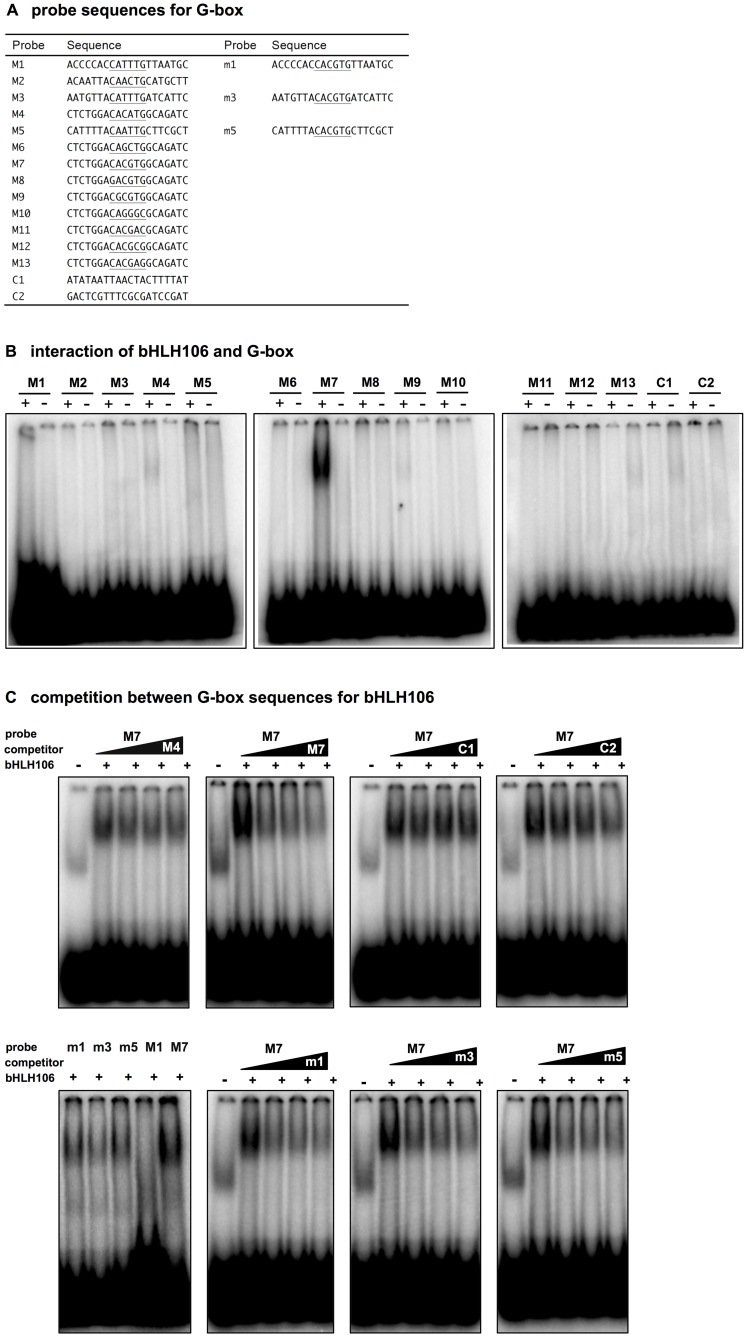
Interaction of bHLH106 with a variety of G-box sequences.Interactions were examined by electrophoresis mobility shift assay (EMSA). (A) Nucleotide sequences of regions containing a possible G-box were employed for EMSA as probes. (B) Thirteen kinds of 20-mer G-box sequences consisting of 5′-C/G
A/GNNT/G/A
G/C-3′ (M1 to M13) and arbitrary degenerate probes (C1 and C2). The “+” and “-”denote the presence or absence of bHLH106 protein in EMSA. (C) Competition experiments using the 5′-CACGTG-3′ sequences against the bHLH106 protein.